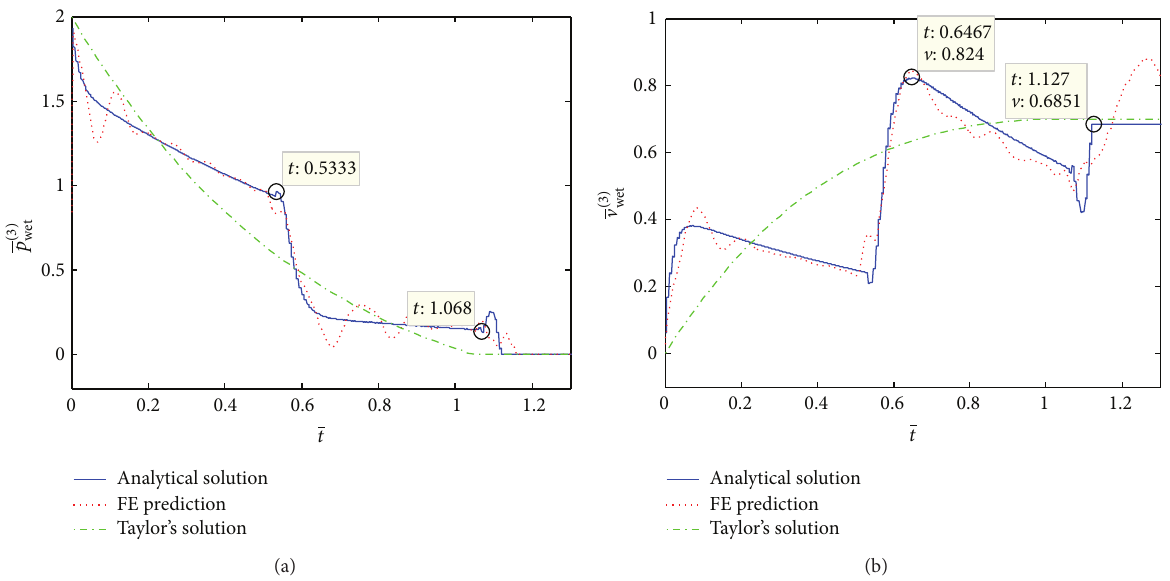
Figure 14: Nondimensional time histories of (a) nondimensional wet surface pressure and (b) nondimensional velocity for the panel with girder (I-shaped).